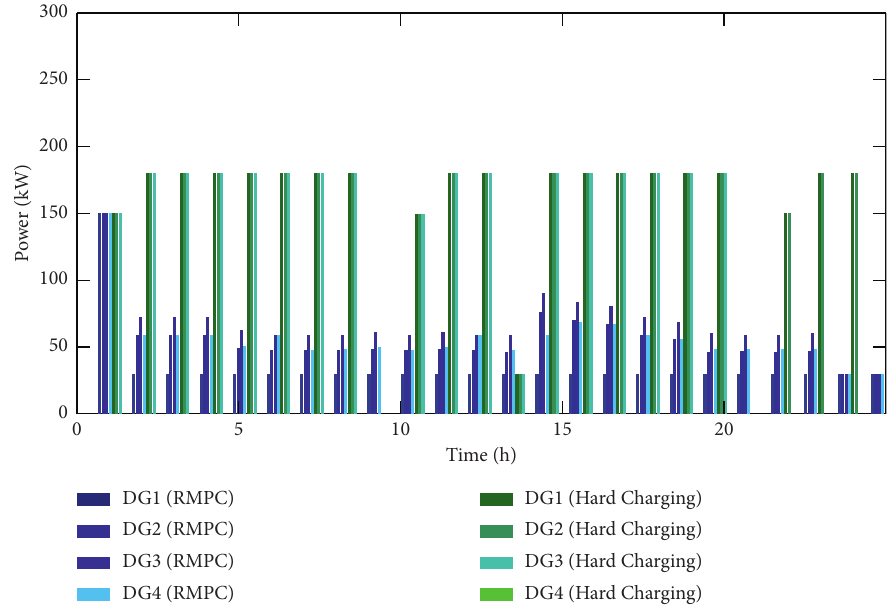
Figure 11: Comparison of the output of DGs between RMPC and HC